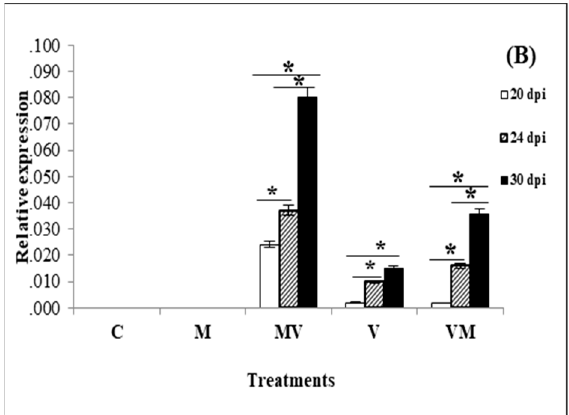
Figure 2. The result of RT-qPCR shows an accumulation level of viral infection by TBSV ( A ) and ToMV( B ) in uninfected control plants without AM fungi (C), uninfected control plants with AM fungi (M), TBSV/ToMV -infected plants without AM fungi (V), TBSV/ToMV -infected plants before mycorrhiza (VM) inoculation and inoculated plants with mycorrhiza before TBSV/ToMV infection (MV) at three stages of infection (20, 24 and 30 dpi). For each treatment, three replicates were tested by qPCR. A significant difference between the expressions of viral gene for each treatment in three different times is shown by (*) [using repeated measures ANOVA and Bonferroni post-hoc test ( p < 0.001)]. Error bars represent SD.